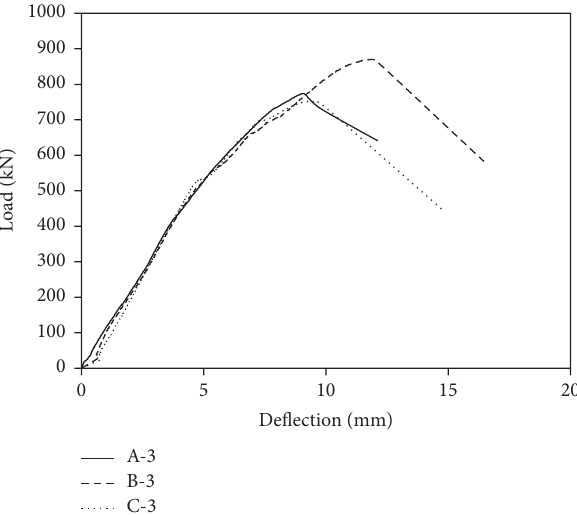
Figure 10: Load-deflection curves for three different arrays of openings in GFRP shear reinforcement.